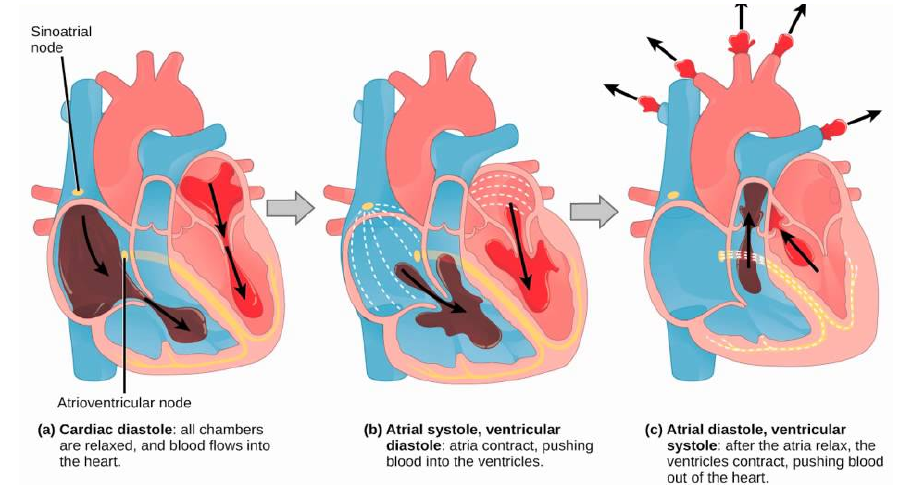
Figure 2. The heart cycle: The mammalian heart & cardiac